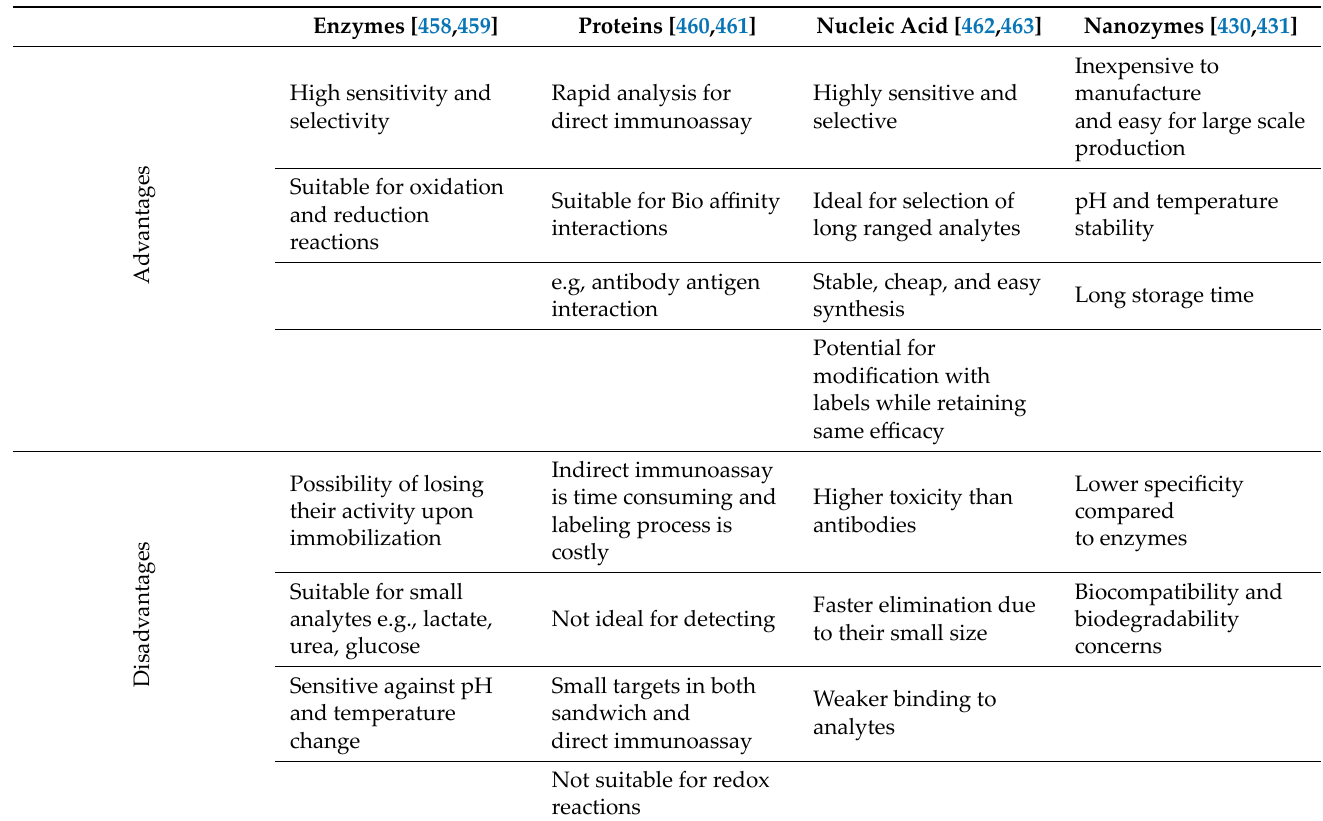
Table 3. Summary of the advantages and disadvantages in various biosensor‑based bio elements